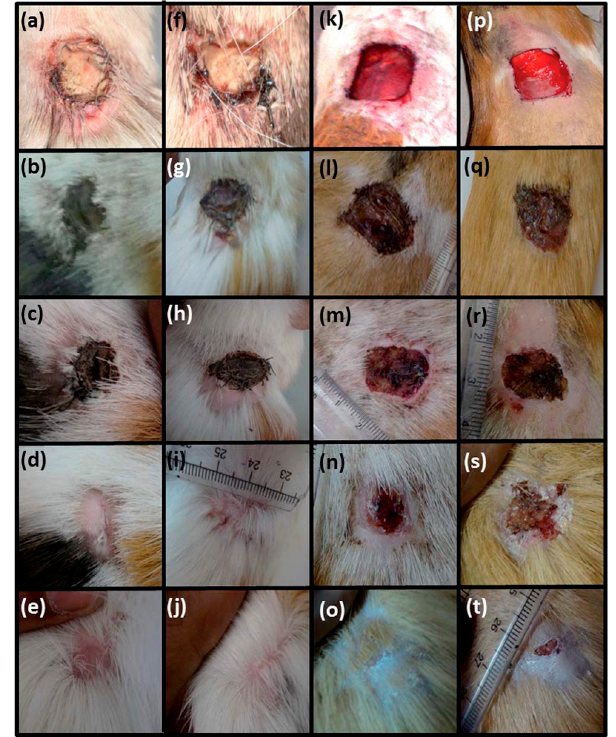
Figure 20. Wound healing activity of the membrane on the first day ( a , f , k , p ); on the fifth day ( b , g , l , q ); on 10th day ( c , h , m , r ); on 20th day ( d , i , n , s ) and on 30th day ( e , j , o , t ) of implantation. The first column ( a – e ) indicates neat polycaprolactone (PCL) membranes; the second column ( f – j ) indicates PCL membrane incorporated with 1 wt % ZnO nanoparticles; the third column ( k – o ) indicates povidone–iodine treated wounds (positive controls) and the fourth column ( p – t ) indicates negative controls. Reproduced with permission from reference [22]. Copyright (2014) Royal Society of Chemistry.